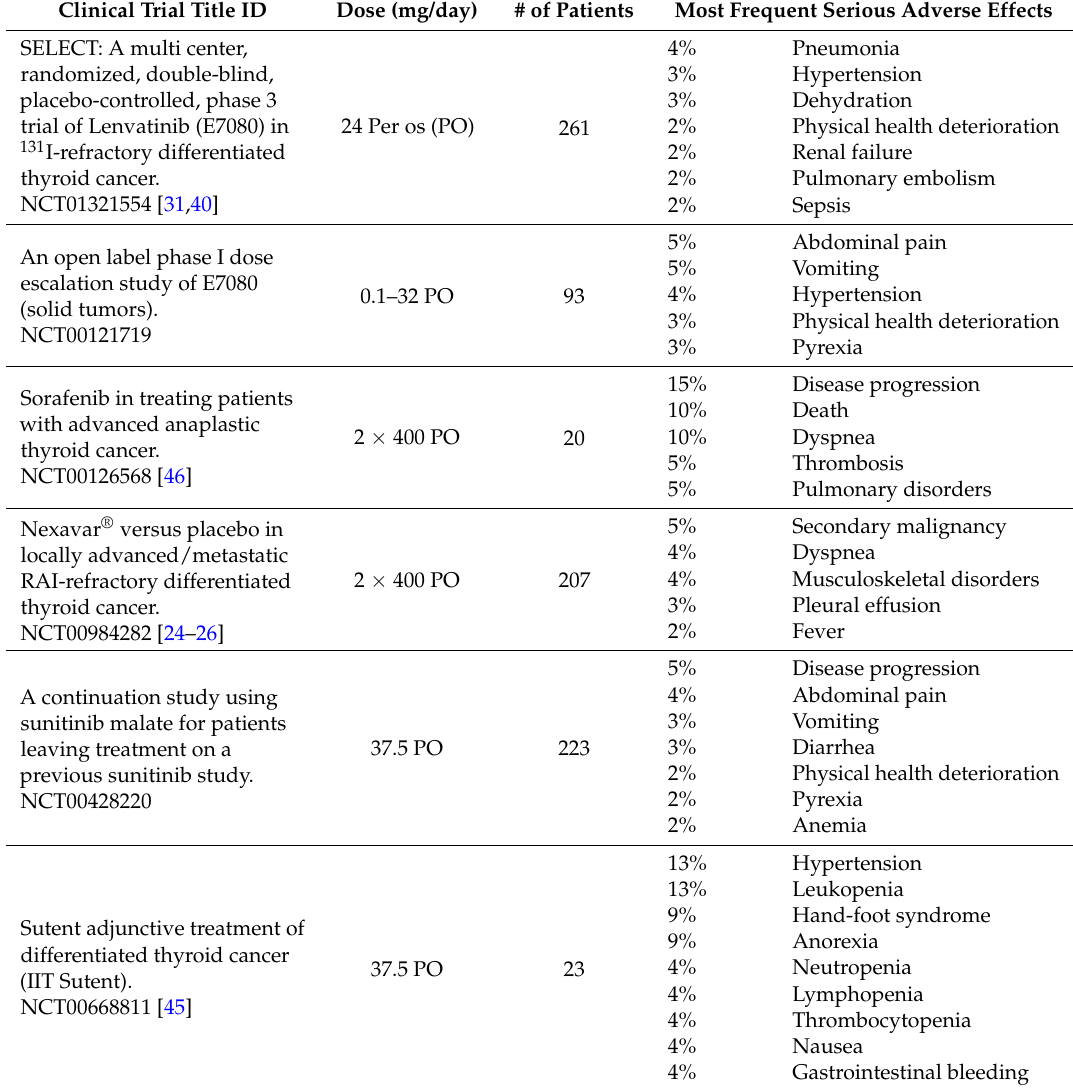
Table 3. Overview of serious AE observed in clinical trials investigating TKI treatment; website